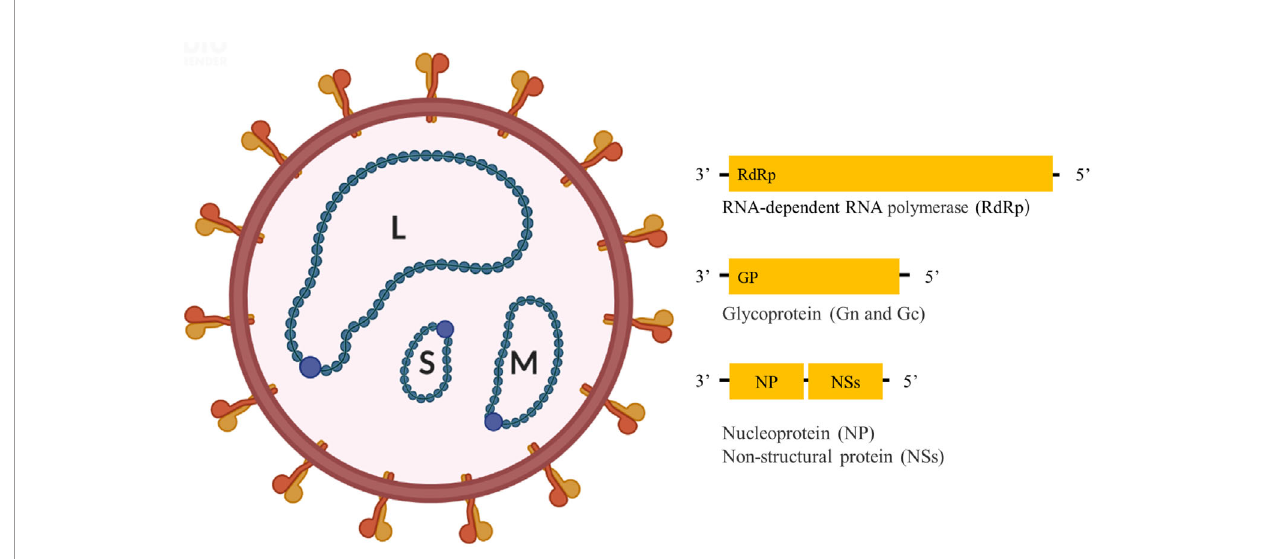
FIGURE 1 | Schematic diagram of SFTSV